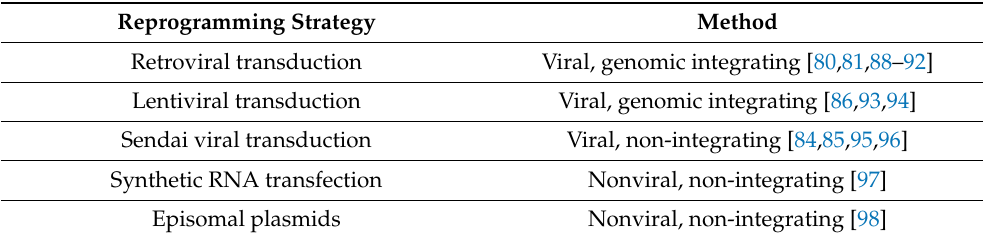
Table 2. Overview of current strategies used in the reprogramming of ciPSCs.